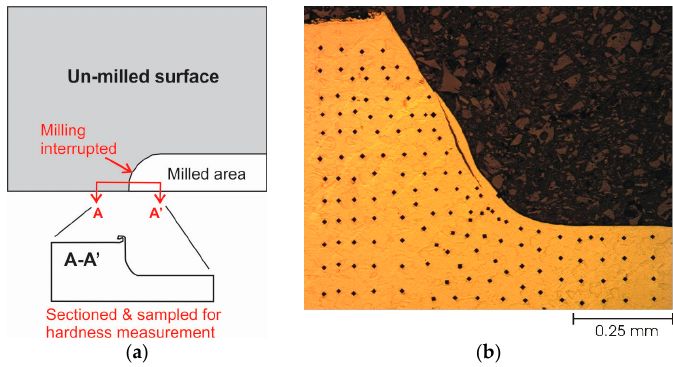
Figure 2. Illustration of metallographic sample location from milling interrupted workpiece for hardness measurement: ( a ) schematic of workpiece viewing from top and sampled A-A’ cross section viewing from side, and ( b ) an area of an A-A’ metallographically prepared sample with hardness indentations near the milled front.